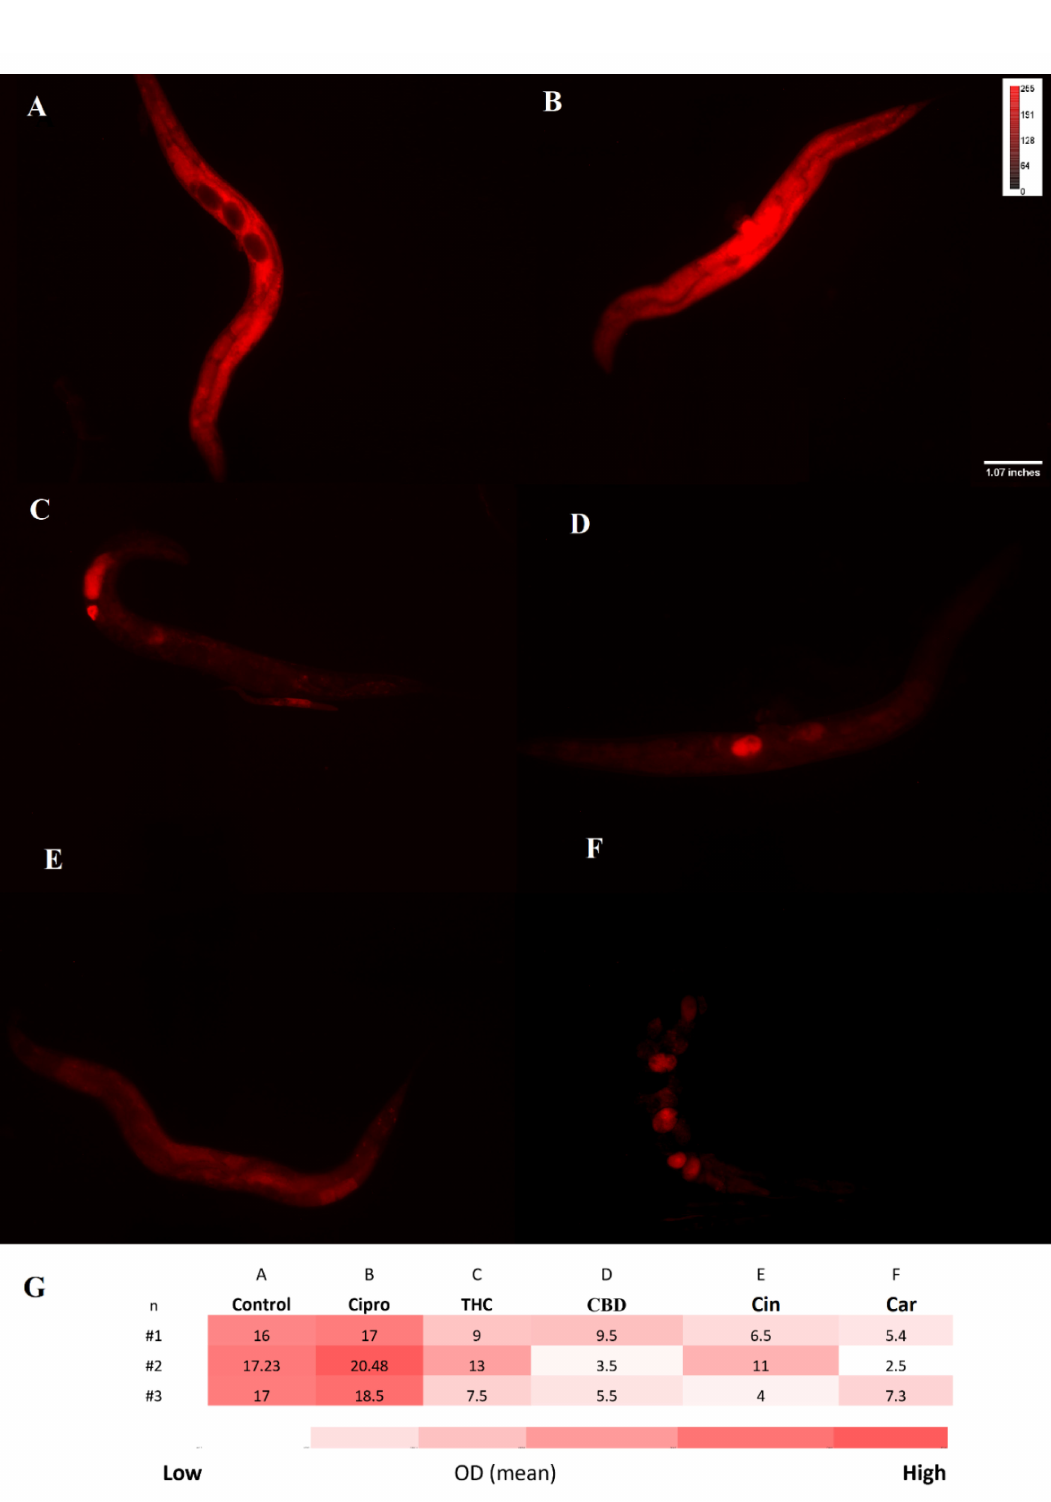
Figure 6. DHE staining for O 2 − level. Fluorescence intensity of all C. elegans O 2 − levels was measured after exposure to control (PBS) ( A ), ciprofloxacin ( B ), THC ( C ), CBD ( D ), cinnamaldehyde ( E ), and carvacrol ( F ) by DHE probe. Heatmap on O 2 − level of C. elegans in the treated and untreated groups shown in panel ( G ). n = trial